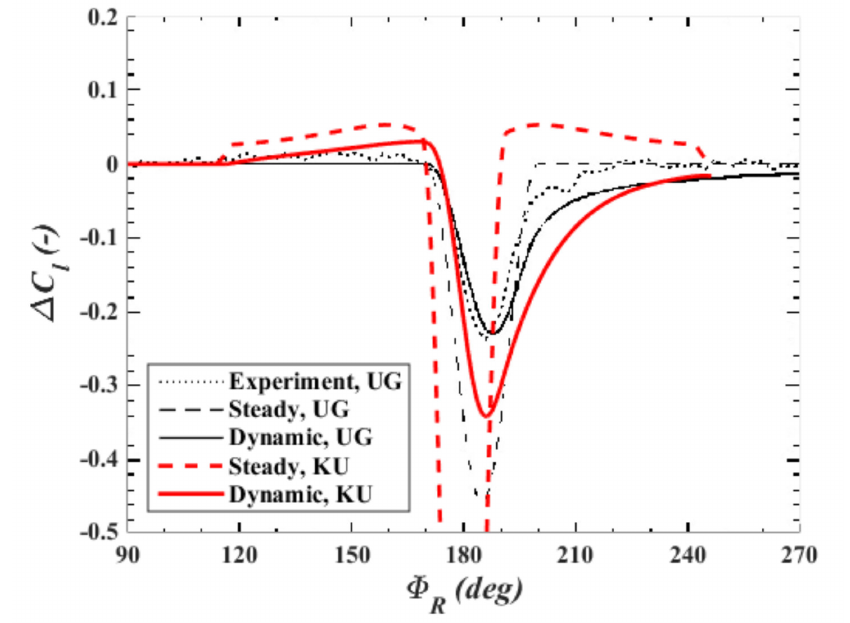
Figure 11. Deviations in the lift coe ffi cient at η B = 75% according to the present method with the present threshold, C d = 1.8, V T = 36.0 m / s